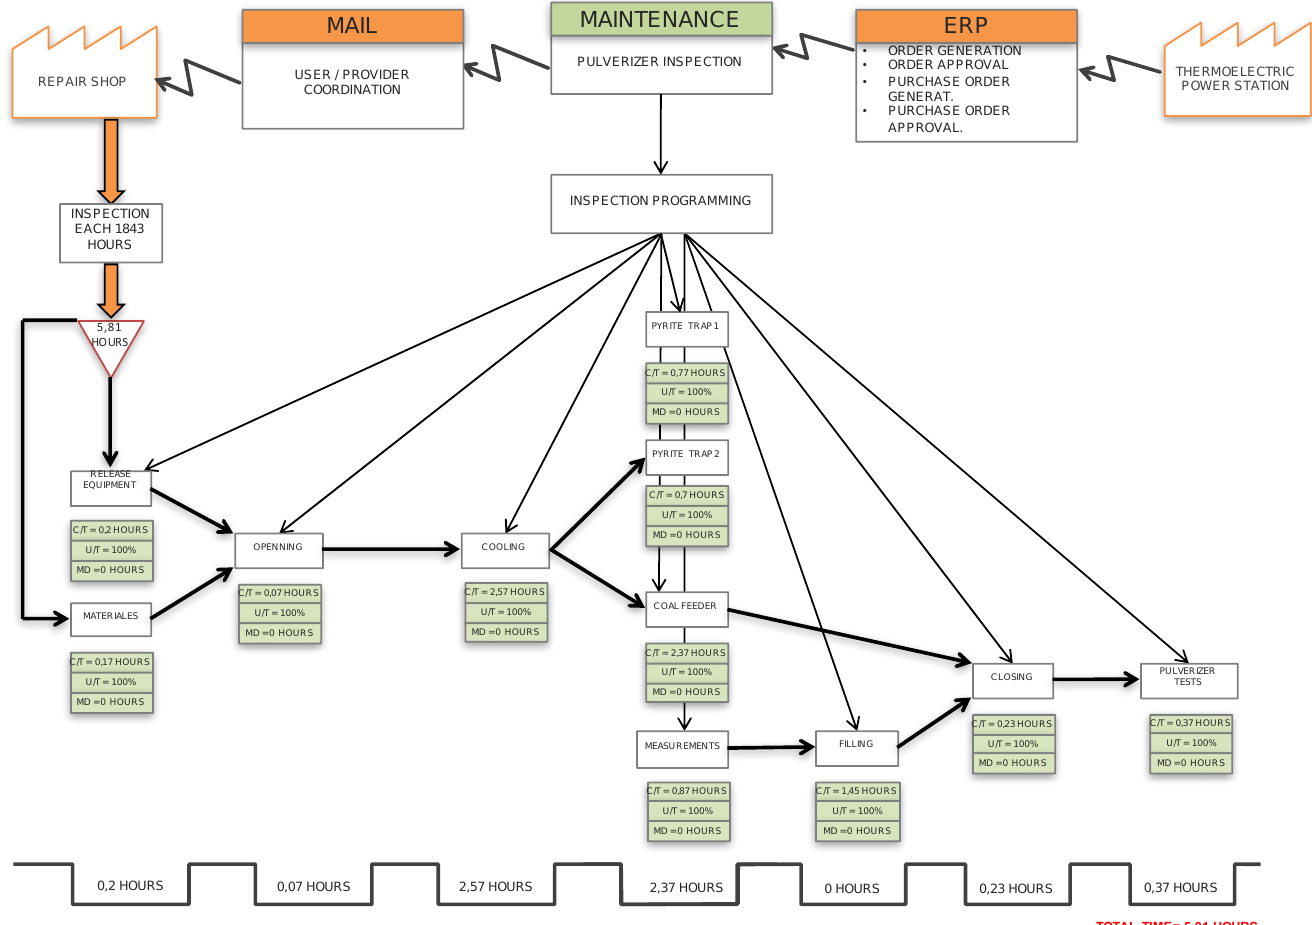
Figure 10. The value stream map of the future state.